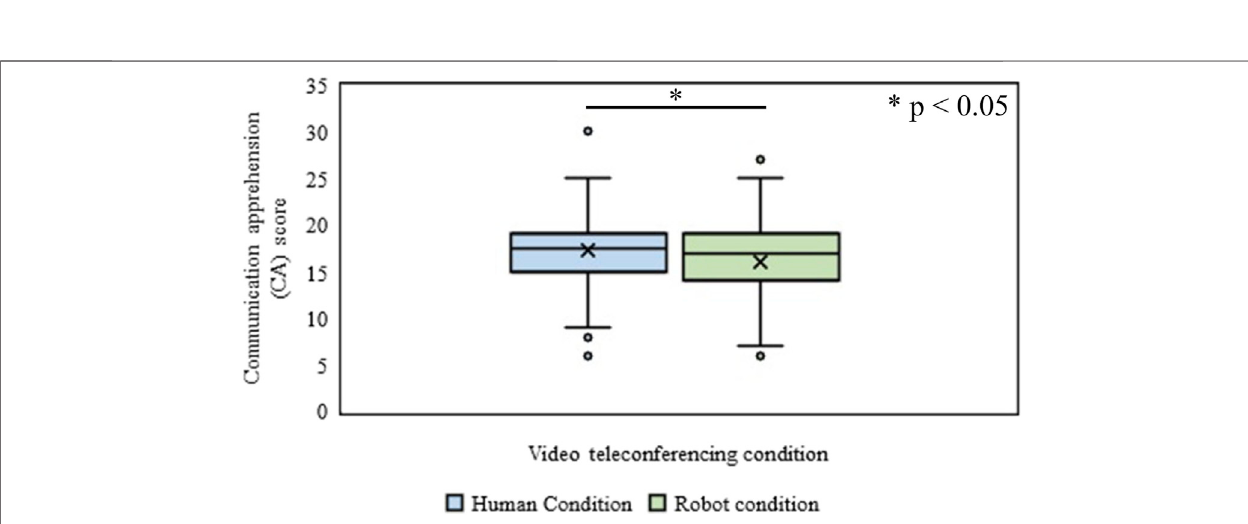
FIGURE8| Video stimulifromExperiment- Ⅱ : (A) Human condition(withavertedinterviewergaze); (B) Robotcondition(withinterviewer ’ sgazetowardrobotavatar controlled by the interviewee).